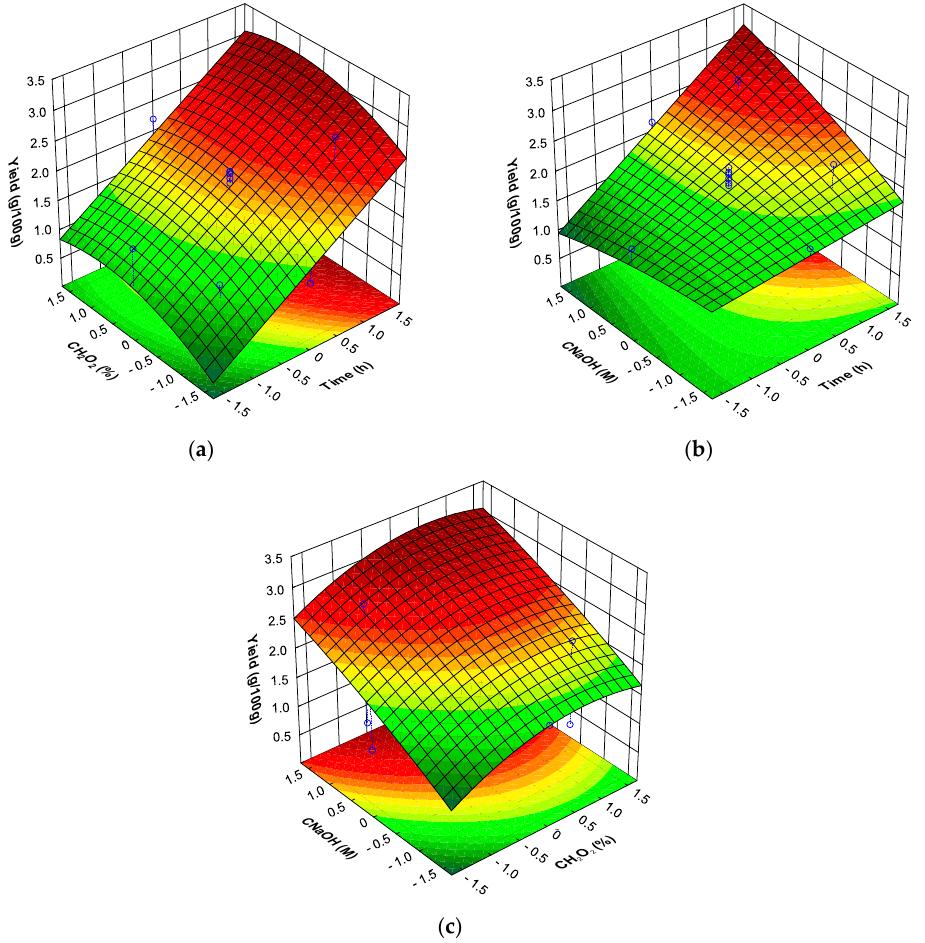
Figure 1. Response surfaces for mushroom DFI yield as a function of: ( a ) time and hydrogen peroxide concentration (at sodium hydroxide concentration level of 1.682); ( b ) time and sodium hydroxide concentration (at hydrogen peroxide concentration level of 1); ( c ) hydrogen peroxide concentration and sodium hydroxide concentration (at time level of 1.682).